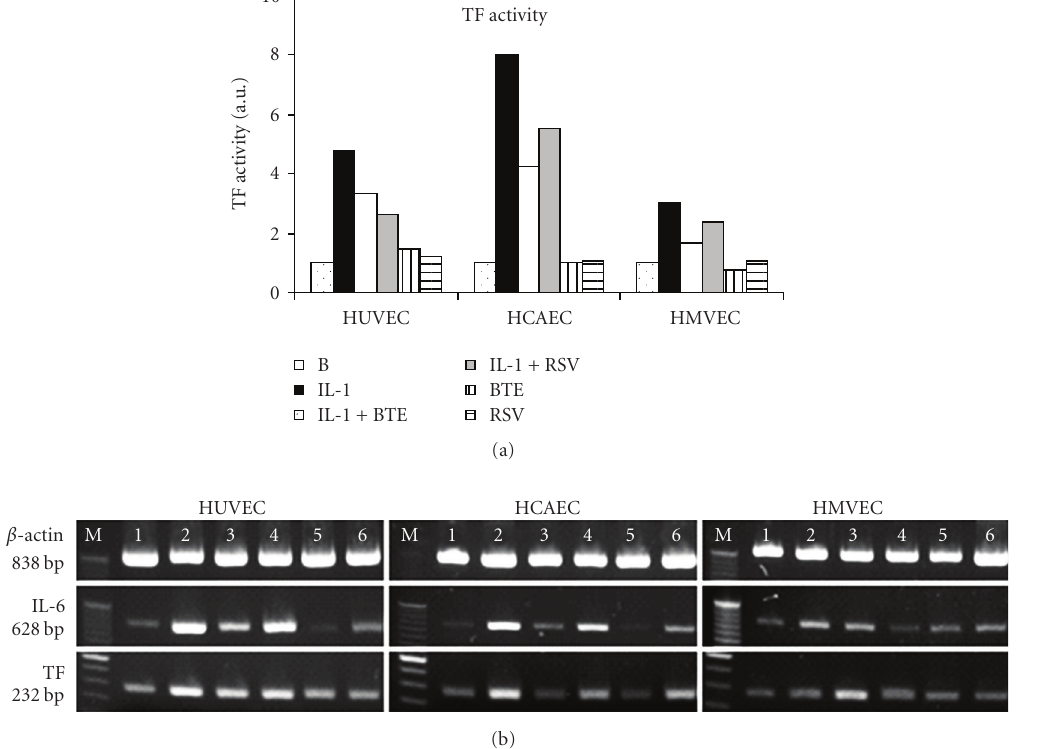
Figure 3: (a) TF activity was measured in the indicated treatments. Data are presented as arbitrary units, which indicate fold-change above background TF levels and were generated from the mean of three separate experiments. (b) mRNA expressions of β -actin, IL-6, and TF are shown from HUVEC, HCAEC, and HMVEC incubated with IL-1 β (1000pg/mL) in the absence or presence of BTE (40 μ g/mL) and RSV (40 μ M). The treatments of cell cultures were background control (lane 1), IL-1 β 1000 pg/mL (lane 2), IL-1 β + BTE (lane 3), IL-1 β + RSV (lane 4), BTE (lane 5), and RSV (lane 6). Results shown are from one representative experiment of two separate ones